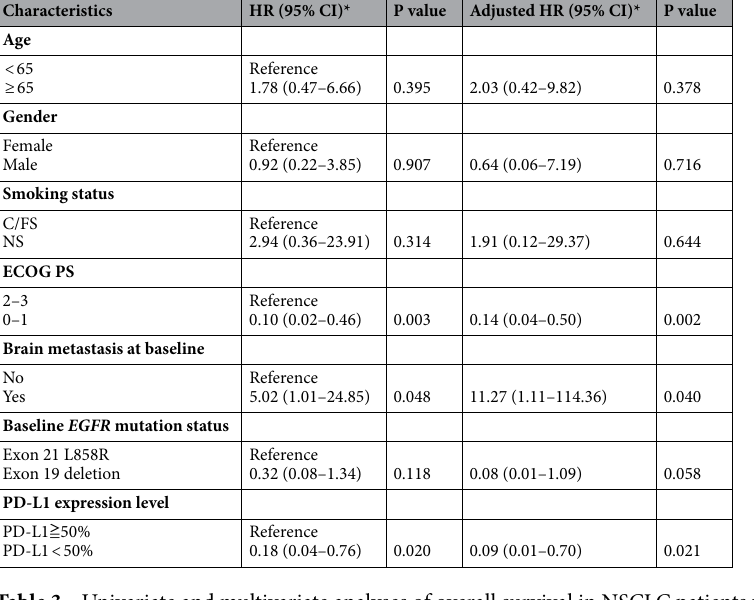
Table 3. Univariate and multivariate analyses of overall survival in NSCLC patients with osimertinib treatment (n = 71). NSCLC, non-small-cell lung cancer; HR, hazard ratio; CI, confidence interval; C/FS, current/former-smokers; NS, never smoker; ECOG PS, Eastern Cooperative Oncology Group performance status; EGFR, epidermal growth factor receptor; PD-L1, Programmed death-ligand 1. *By Cox proportional hazard